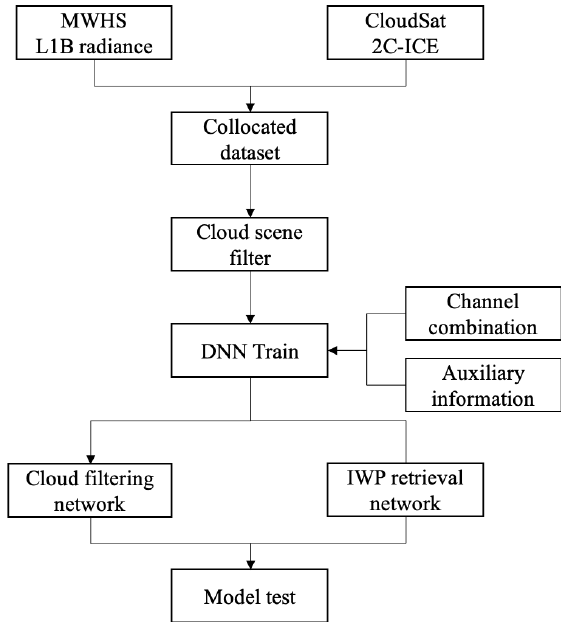
Figure 8. The schematic of the MWHS retrieval based on the DNN model.